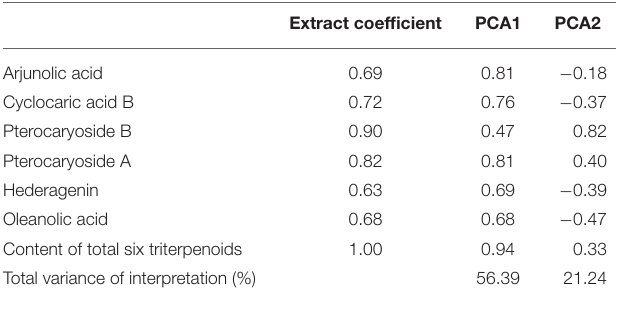
TABLE 3 | Results of PCA analysis of triterpenoids of C. paliurus . Extract coefficient